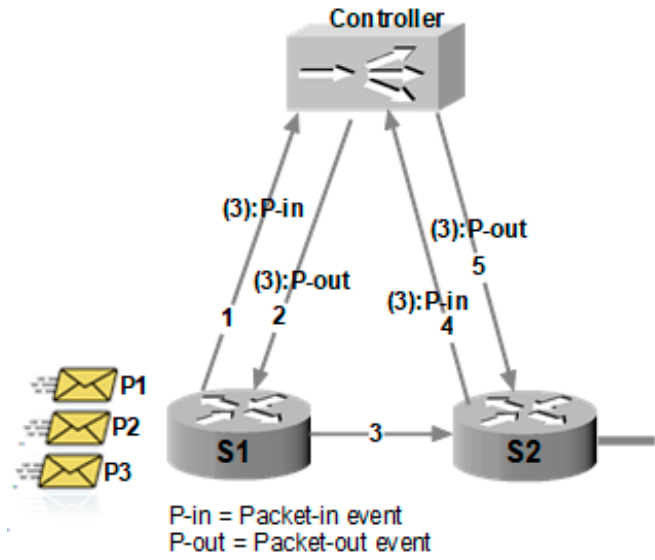
Figure 3. Example of reactive entry installation.